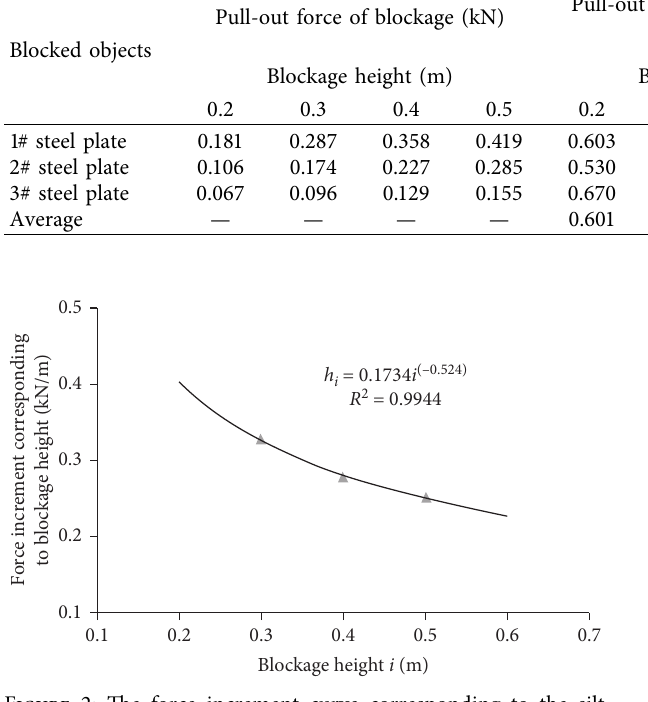
Figure 2: The force increment curve corresponding to the silt increment per unit width at intervals of 0.1